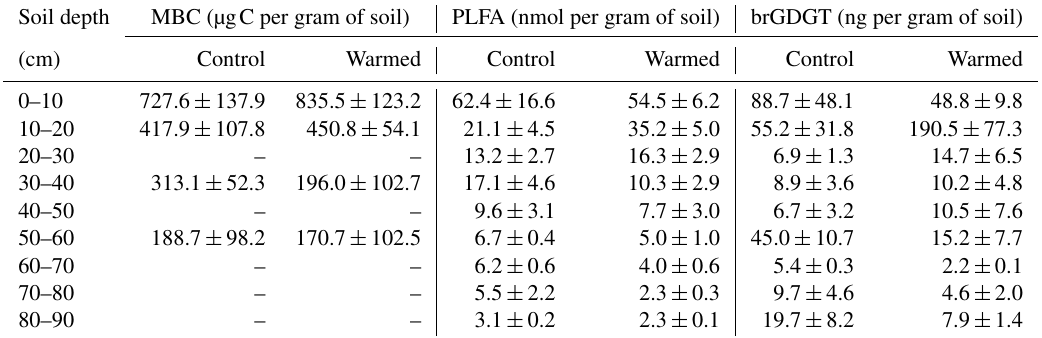
Table B2. Concentrations of MBC using chloroform fumigation extraction (Soong et al., 2021), PLFAs, and brGDGTs in control plots and warmed plots (mean ± SE; n = 3).